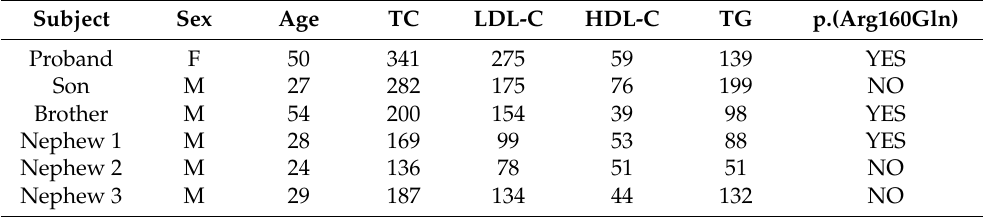
Table 2. In silico predictions of the impact of the Arg160Gln mutation on PCSK9 protein using different online